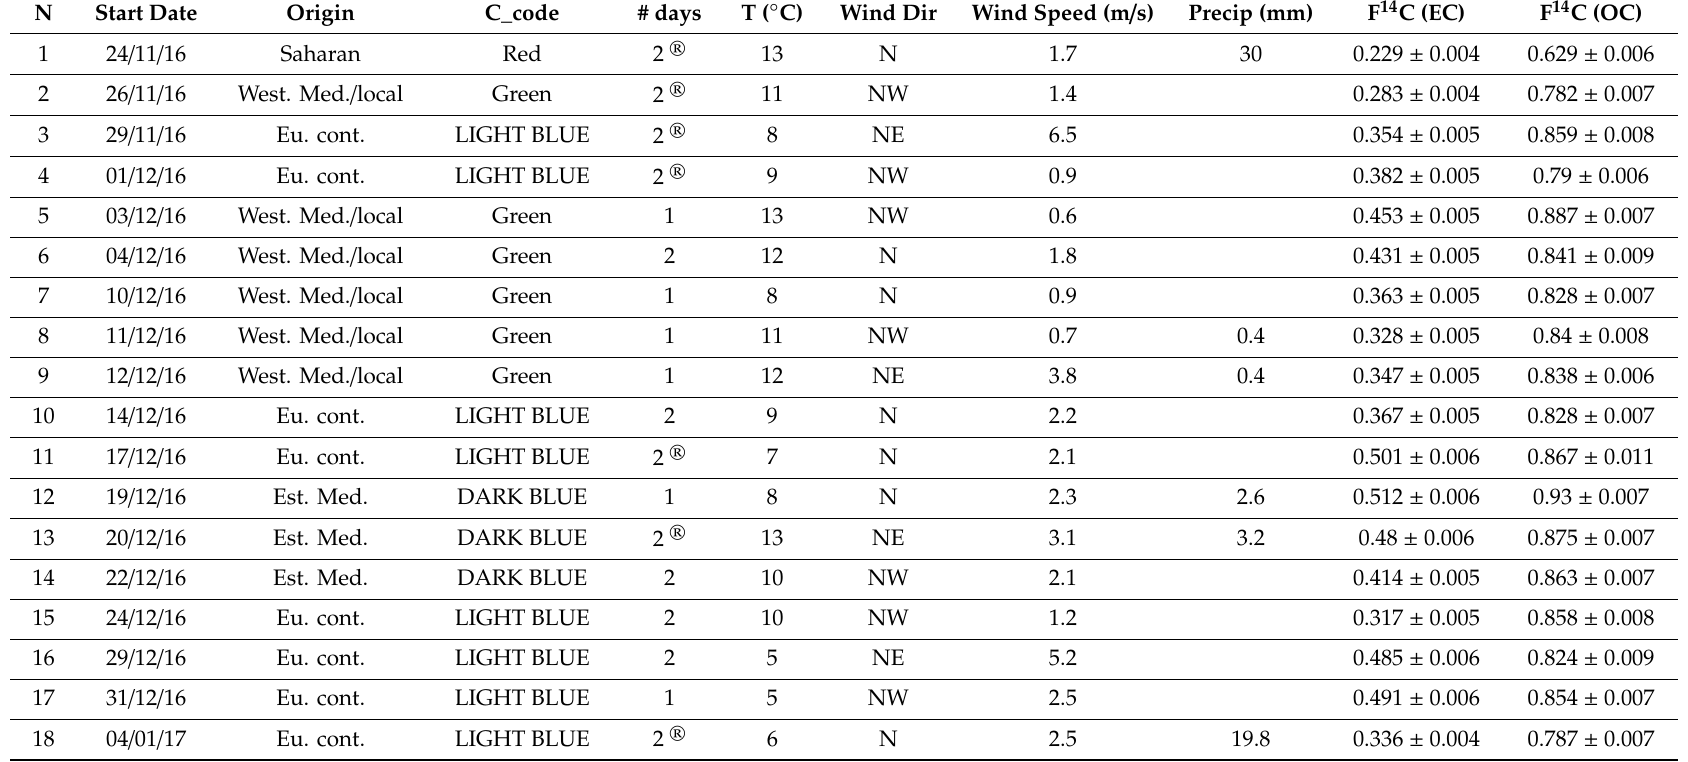
The symbol ® indicates samples which are not measured together for EC